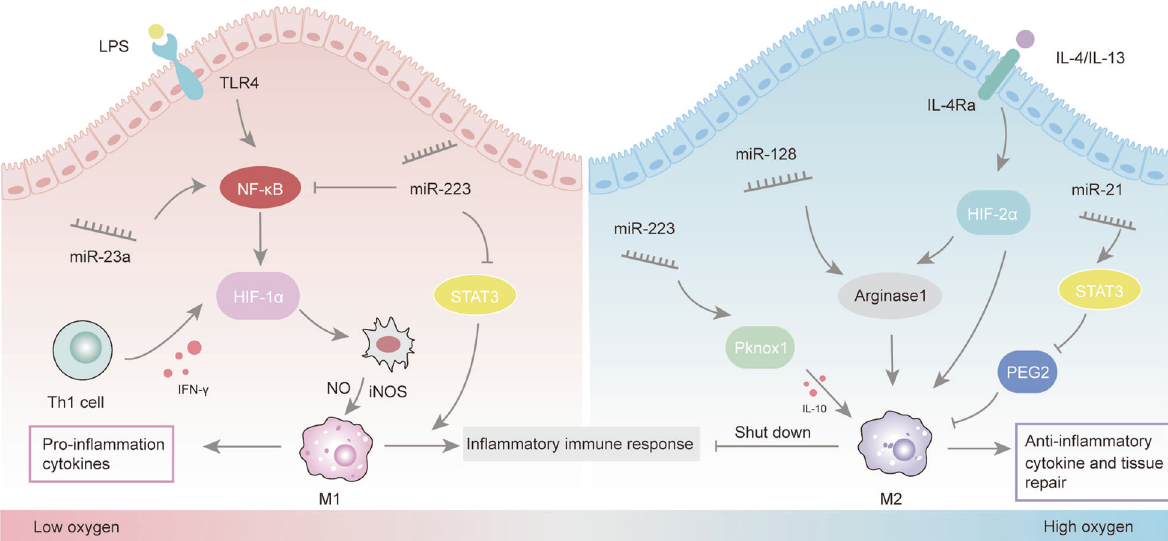
Fig. 3 Different HIF subtypes affect the polarization phenotype of macrophages. M1 signals such as IFN- γ and LPS promote the expression of HIF-1 α , while M2 signals such as IL-4 and IL-13 facilitate the accumulation of HIF-2 α . TLR4 was highly expressed in in fi ltrating macrophages, while the M2 response stimulated by IL-4 was inhibited under hypoxia. HIF-1 α drives the expression of M1 macrophage, while HIF-2 α is more closely related to M2 macrophage. Different miRNA can regulate the polarization of macrophages through the HIF pathway and affect the occurrence and development of in fl